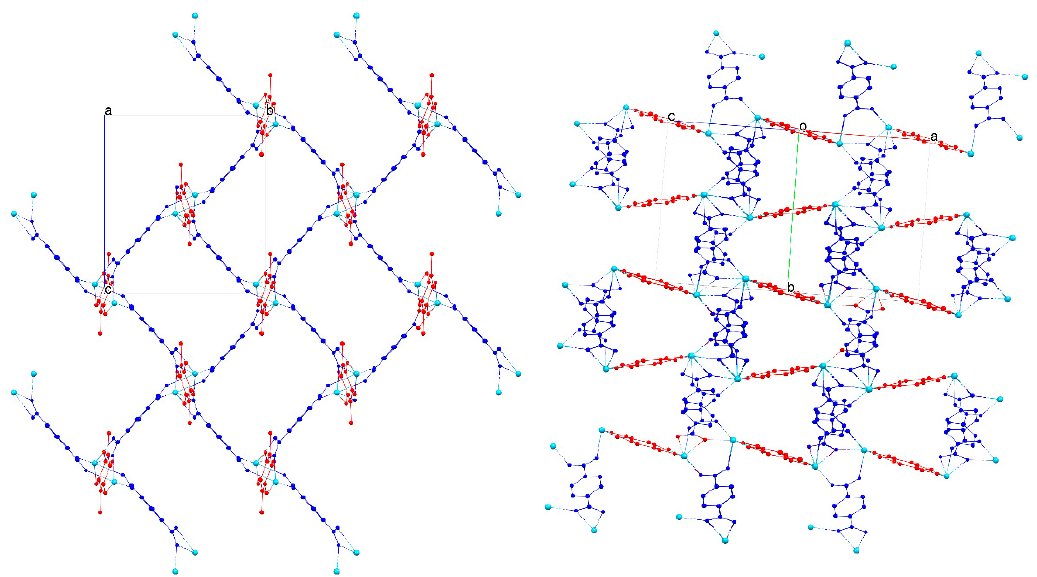
Figure 6. The fragment of crystal packing of 3 along the (100) (left) and (101) (right) vectors. DMF molecules are omitted for clarity. Color code: La, light blue; anilic ligands, red; dicarboxylate ligands, blue.